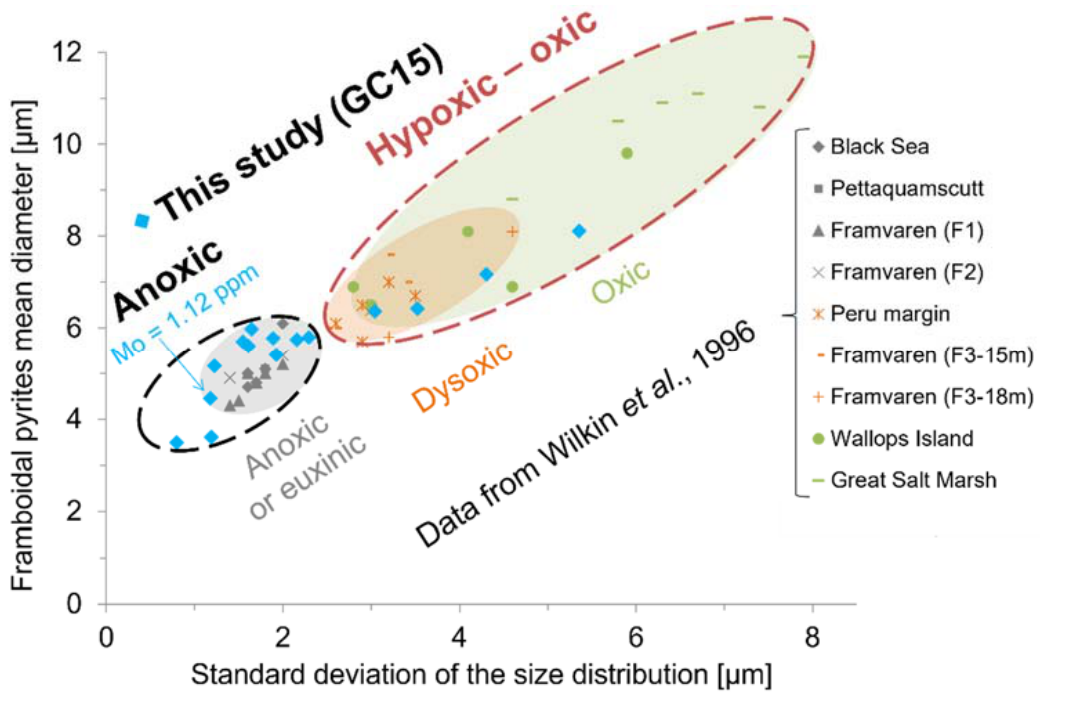
Figure 9. Mean diameter of framboidal pyrites plotted as a function of the standard deviation of the size distribution. Data from Wilkin et al. [19]—a study based on modern sediments—show the characteristics of framboidal pyrites according to the known bottom water oxygenation level. Three oxygenation levels can be defined according to the data of Wilkin et al. [19]: anoxic-euxinic (in grey), dysoxic (in orange) and oxic (in green). The “anoxic” and “hypoxic-oxic” fields are defined based on the results of this study (see text for explanation).